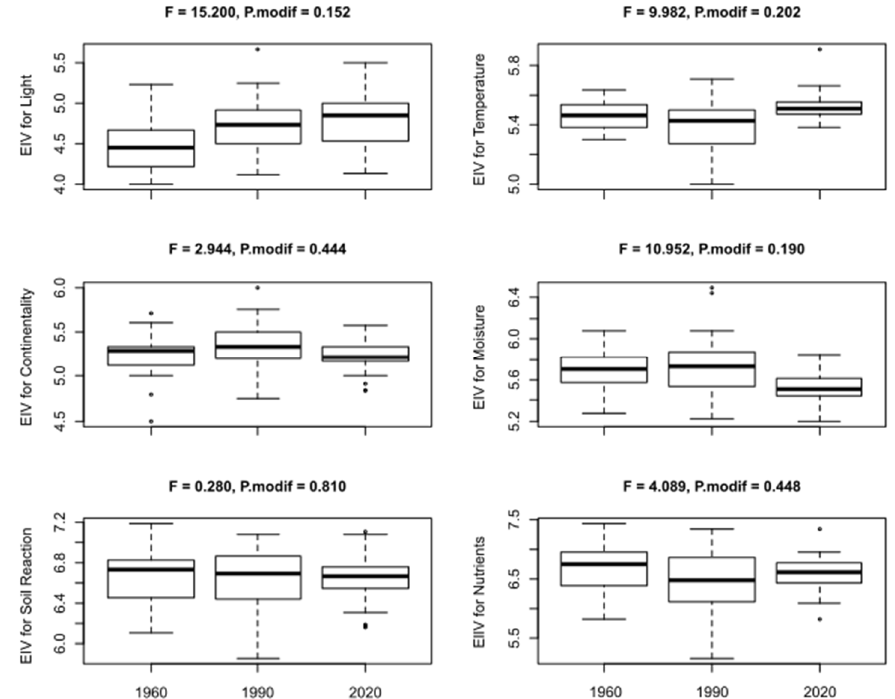
Figure 5. Summary box-and-whisker plots of mean Ellenberg’s Indicator Values (EIVs) for three subsequent surveys of the riparian forest in the Odra River Valley (SW Poland), produced by one-way permutational ANOVA. The central line of each box indicates the median value, box boundaries the lower (25%) and upper (75%) quartiles, and whiskers the range of values. F—test statistic; P. modif. was calculated using a modified permutation test of significance for analysis of mean EIVs [73].